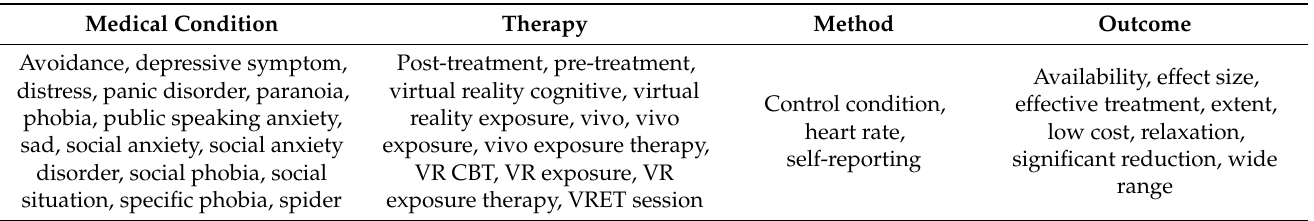
Table 4. Categorized terms associated with anxiety and fear related disorder from Figure 6 (devised by the